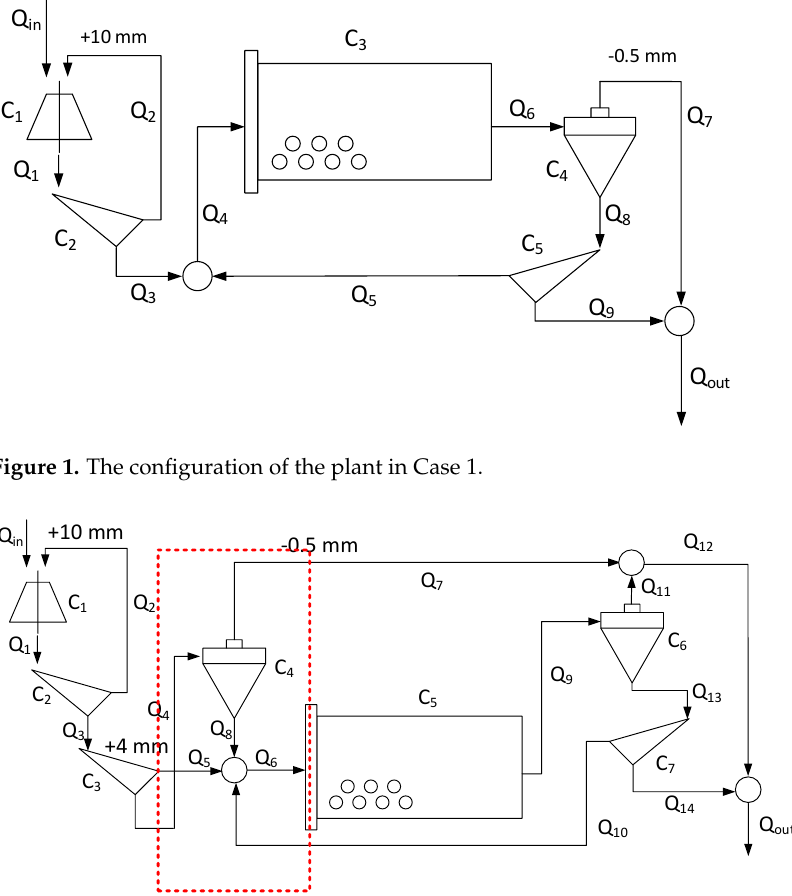
Figure 2. The configuration of the plant in Case 2.